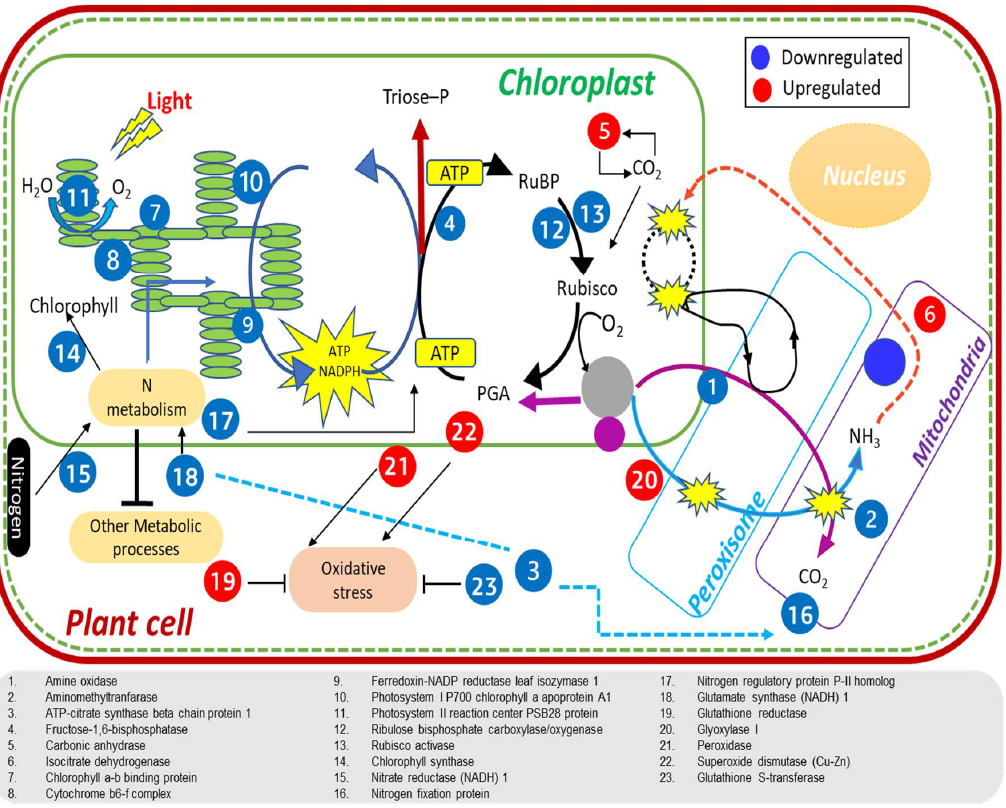
Figure 8. Schematic representation of candidate genes and their differential expression under low– N supply in rice plants. Most of the candidate genes were involved in energy metabolism and photosynthetic processes, but some candidate genes were involved in N metabolism and oxidative defense system. The downregulation of proteins possibly decreased the energy status and assimilatory powers in low-efficient cultivar (Nagina 22) under low–N supply. Besides this, a few proteins were upregulated that probably enhance oxidative defense and energy level in a high-efficient cultivar (Panvel) under low-N supply.